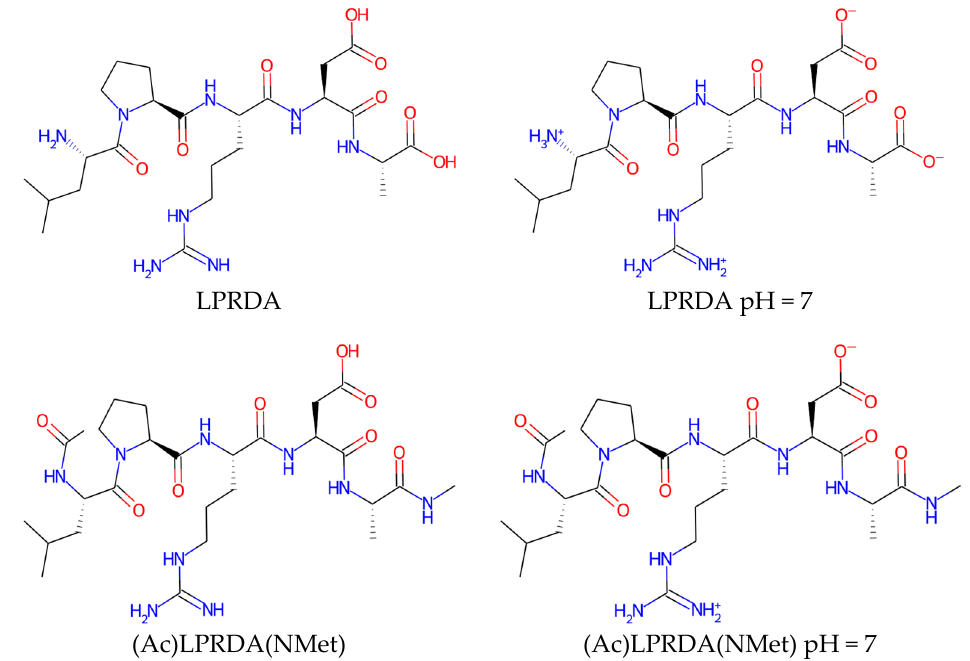
( c ) Figure 9. Surface models of PDB:1T2P ( a ) and PDB:1T2W ( c ) in comparison with the figure (Figure 4A) provided in Wang et al. paper [15] ( b ). PyMol was used to generate the images. The SrtA target for docking was prepared using a regular protocol. All molecules beside protein were removed from the structure. Chain A was used for the simulation. MGLTools v1.5.6 [37] with the standard settings were used to obtain pdbqt files necessary for both AutoDock and AutoDock Vina modeling.